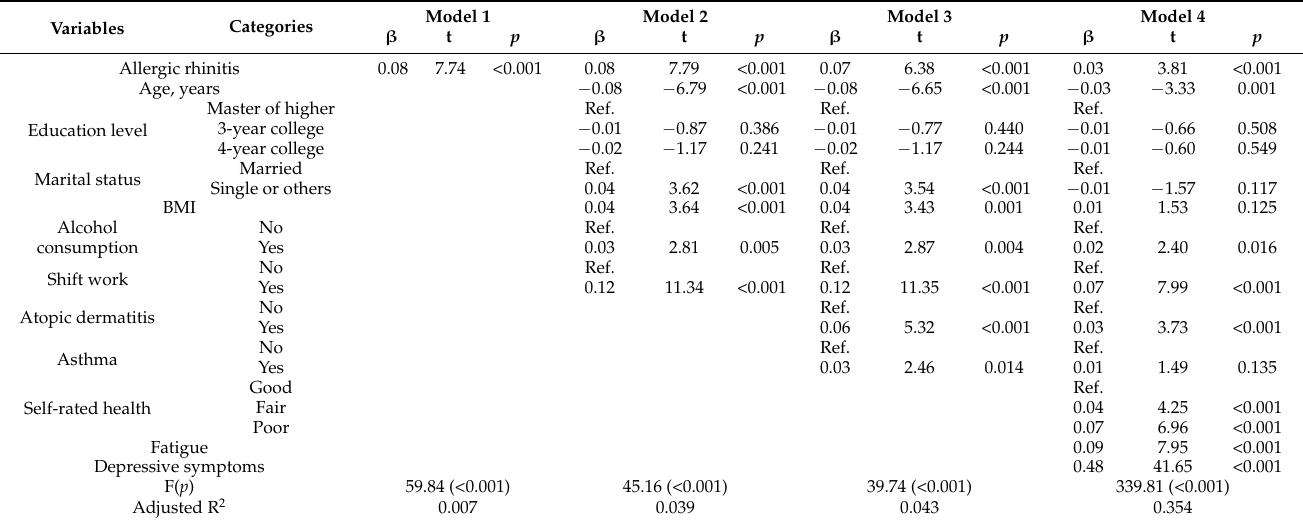
Table 3. Effects of allergic rhinitis on sleep disturbance ( N = 8645).